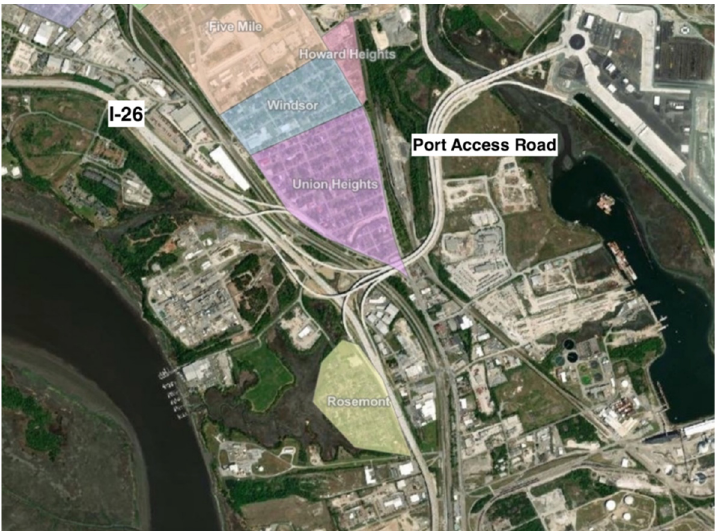
Figure 10. Aerial imagery showing the network of highway infrastructure surrounding and sepa- rating the Rosemont and Union Heights communities.